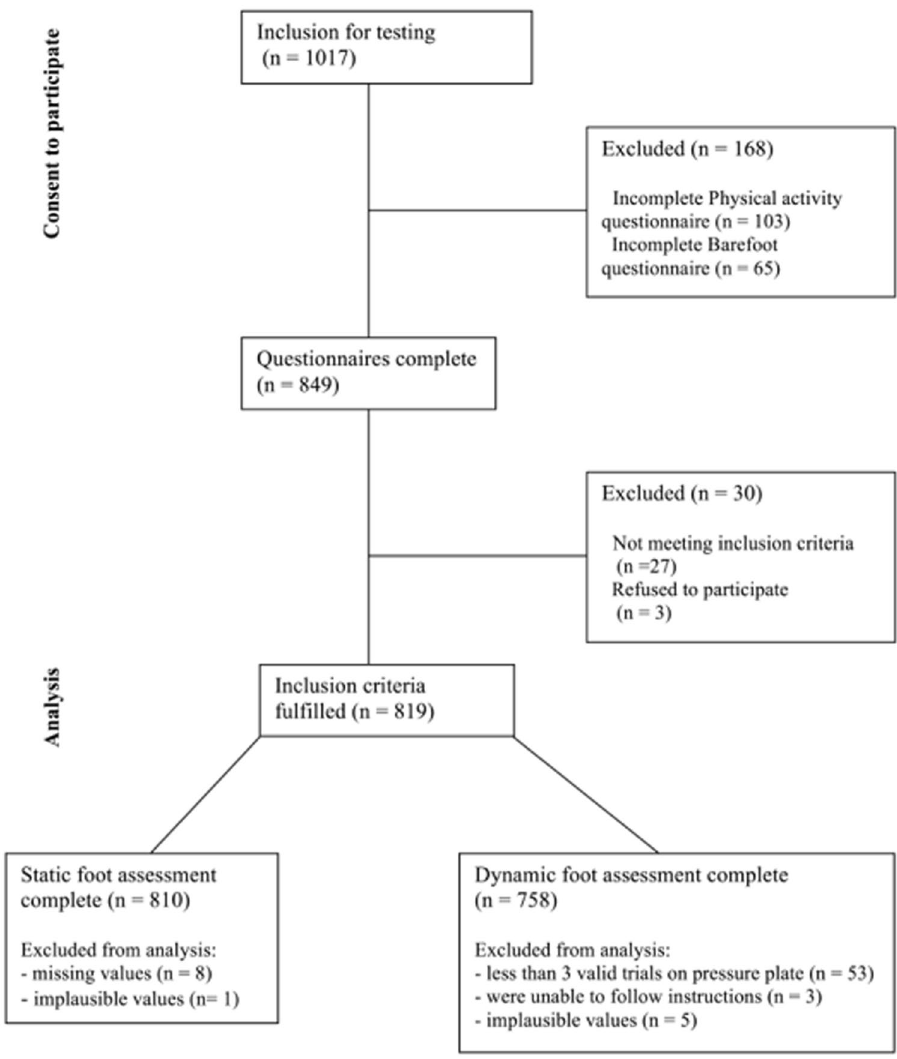
Figure 1. Diagram showing the flow of participants through the